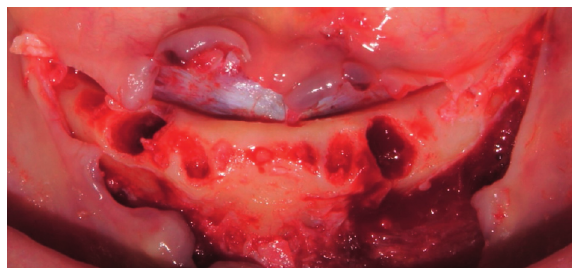
Figure 4: Crestal bone remodeling.